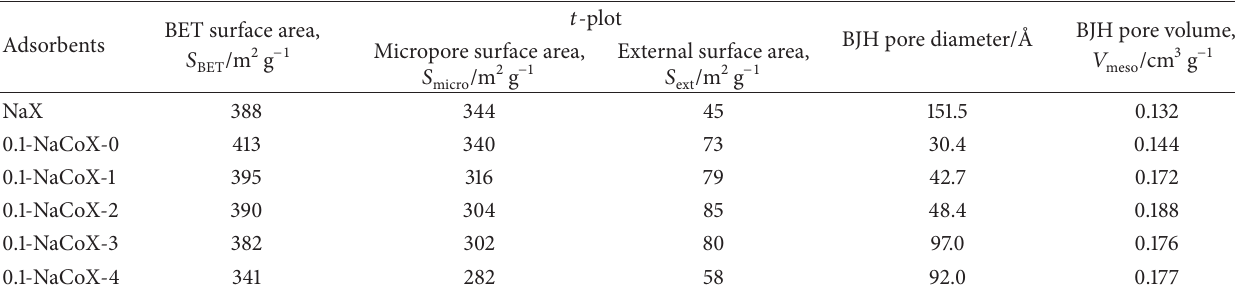
Table 2: The surface area and pore size of NaX zeolites and Co 2+ -exchanged zeolites: NaX zeolite, untreated sample (0.1-NaCoX-0), and